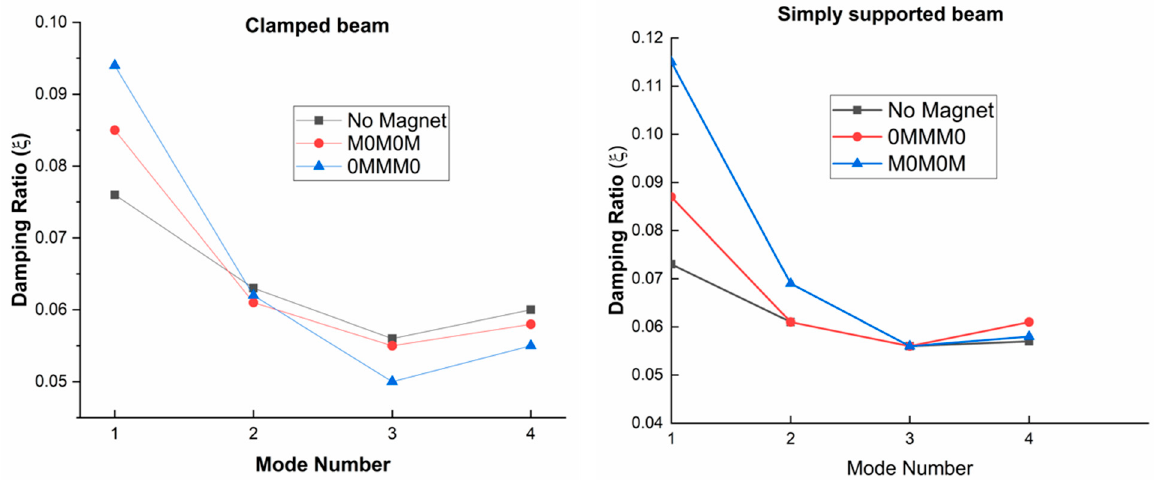
Figure 12. Effect of magnets on damping ratio placed at different positions for simply supported and clamped beam.